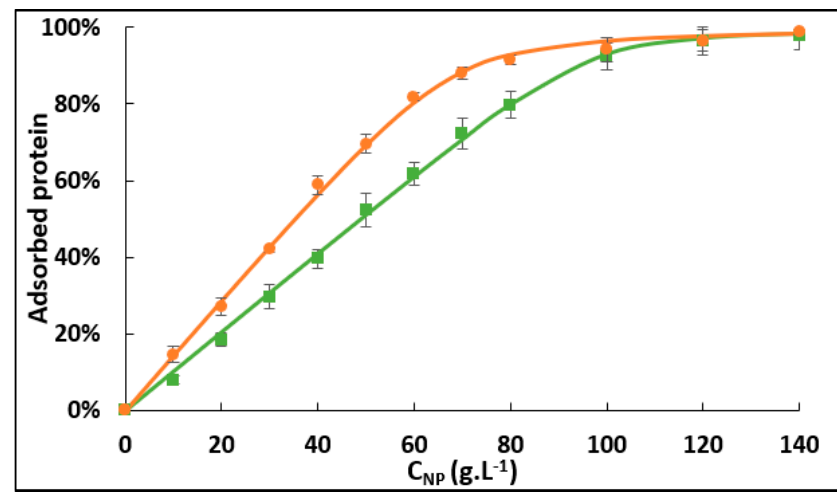
Figure 1. Adsorption isotherms of 1 mM deoxyhemoglobin (orange circles) or oxyhemoglobin (green squares) adsorbed on silica nanoparticles in 0.1 mol.L − 1 phosphate pH 7.0 at 22 °C. Data were fitted using the Langmuir adsorption model (solid lines). Table 1. Adsorption parameters for deoxyhemoglobin (deoxyHb) and oxyhemoglobin (oxyHb) calculated by fitting the adsorption isotherms shown in Figure 1 to the Langmuir model: number of binding sites per nanoparticle (n sites ), maximum amount of adsorbed protein (m ∞ ), adsorption constants (K ads ), and variation of free enthalpy ( ∆ r G 0 ).